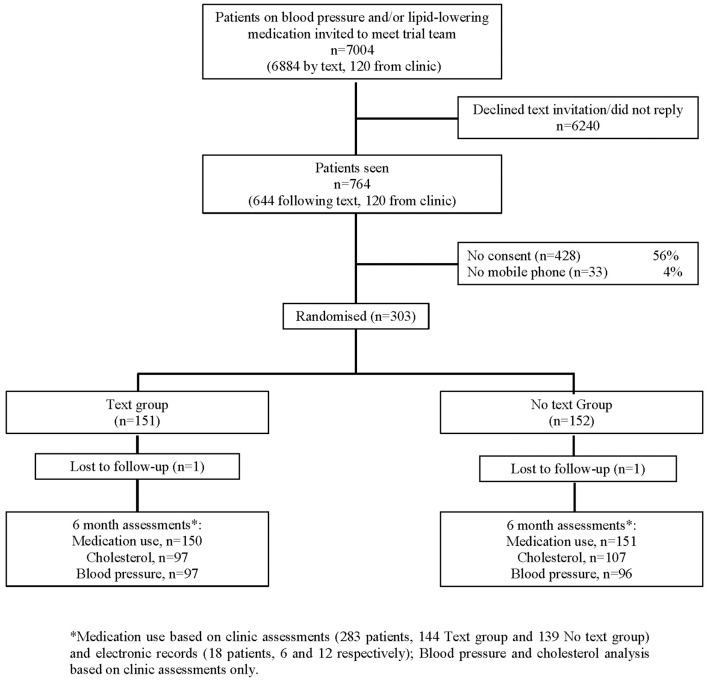
Trial Flow Diagram.